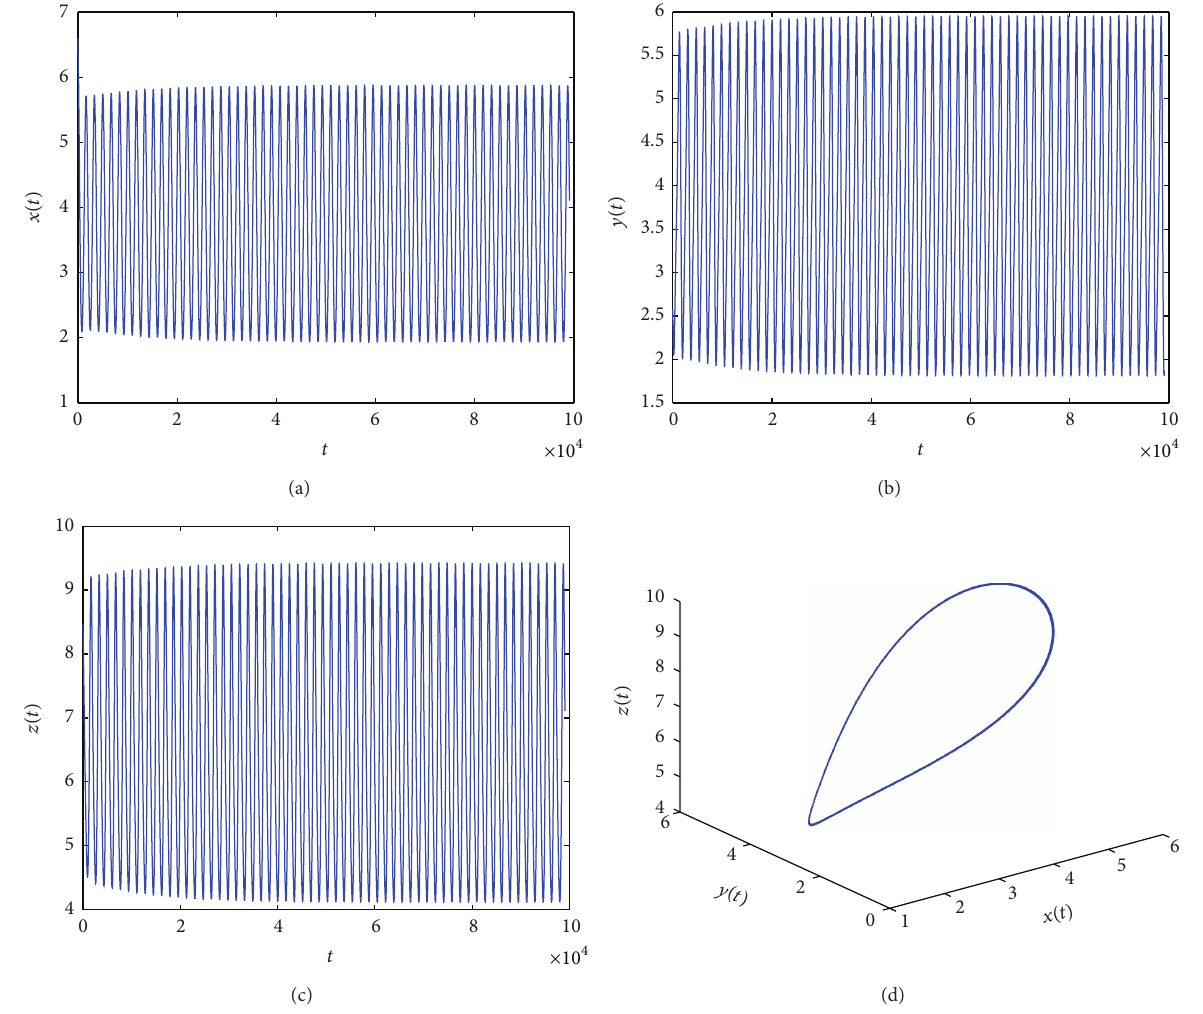
Figure 2: The trajectories and the phase graph of system (83) with 𝑇 = 98 , 𝜀 = 0 , and 𝜏 = 0.4 ; 𝐸 ∗ 2 becomes unstable, and a stable periodic solution bifurcates from equilibrium 𝐸 ∗ 2